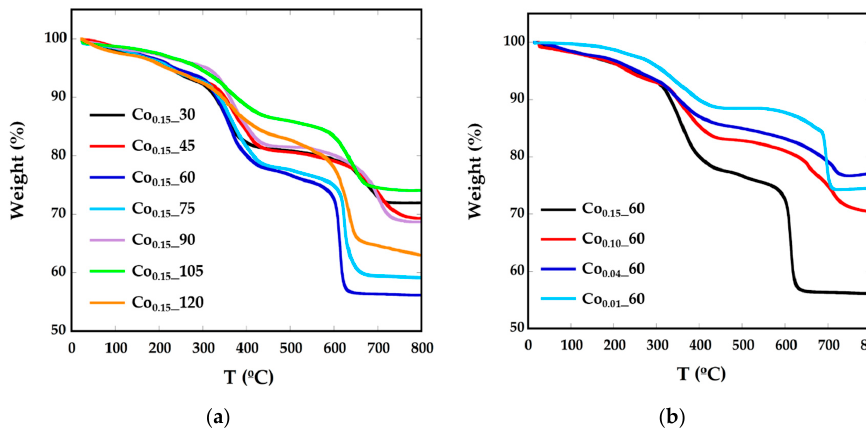
Figure 2. TGA curves of Co x _ t phases for different ( a ) reflux times and ( b ) Co